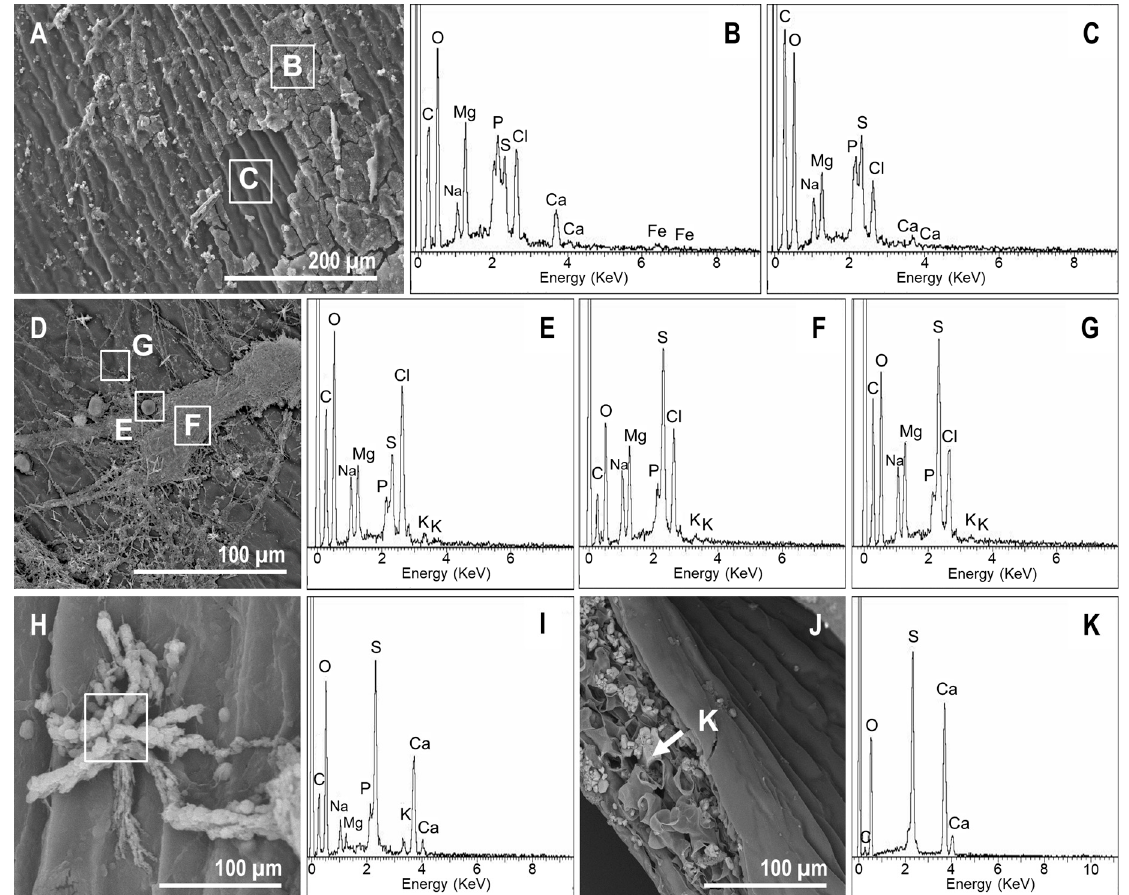
Figure 8. SEM-energy dispersive X-ray spectroscopy (EDXS) images and analyses of mineral precipitates in controls. ( A ) Organic veil covering the surface of the fern at day 7. ( B , C ) Elemental composition of the veil (enriched in Mg, P, Ca, and Cl) and the upper side of the pinna, respectively. ( D ) At day 30, the upper side of the pinna was still covered by the organic mucilaginous veil. Moreover, spherical precipitates with diameters of ~10 µm were detected. Three different points were analyzed (highlighted with dotted rounds): ( E ), spherical precipitates; ( F ), organic veil, and ( G ), fern surface. ( E ) Elemental composition of the spherical precipitates that were rich in Cl, Mg, S, and Na. ( F ) The biofilm formed by the fungi had a similar composition, but presented more P and a depletion of S. ( G ) The surface composition was consistent with the analysis at day 7, but Ca seemed to be absent. ( H ) Observations at day 60. Star-shaped precipitates that were rich in S and Ca. ( I ) appeared on the upper side of the sample. ( J ) At day 60, the occurrence of precipitates enriched in S and Ca ( K ) within the leaf was detected.